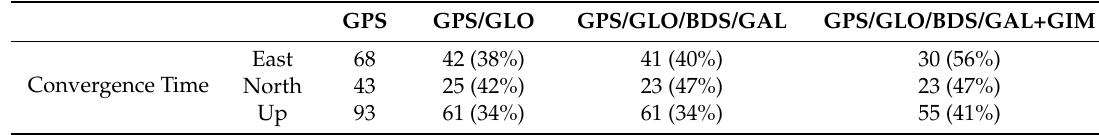
Figure 6. Distribution of convergence time for GPS-only, GPS/GLONASS, GPS/GLONASS/BDS/Galileo, and GPS/GLONASS/BDS/Galileo plus GIM single-frequency PPP using datasets at 12 MGEX stations over seven days. Table 2. Average convergence time for single-frequency PPP (min).